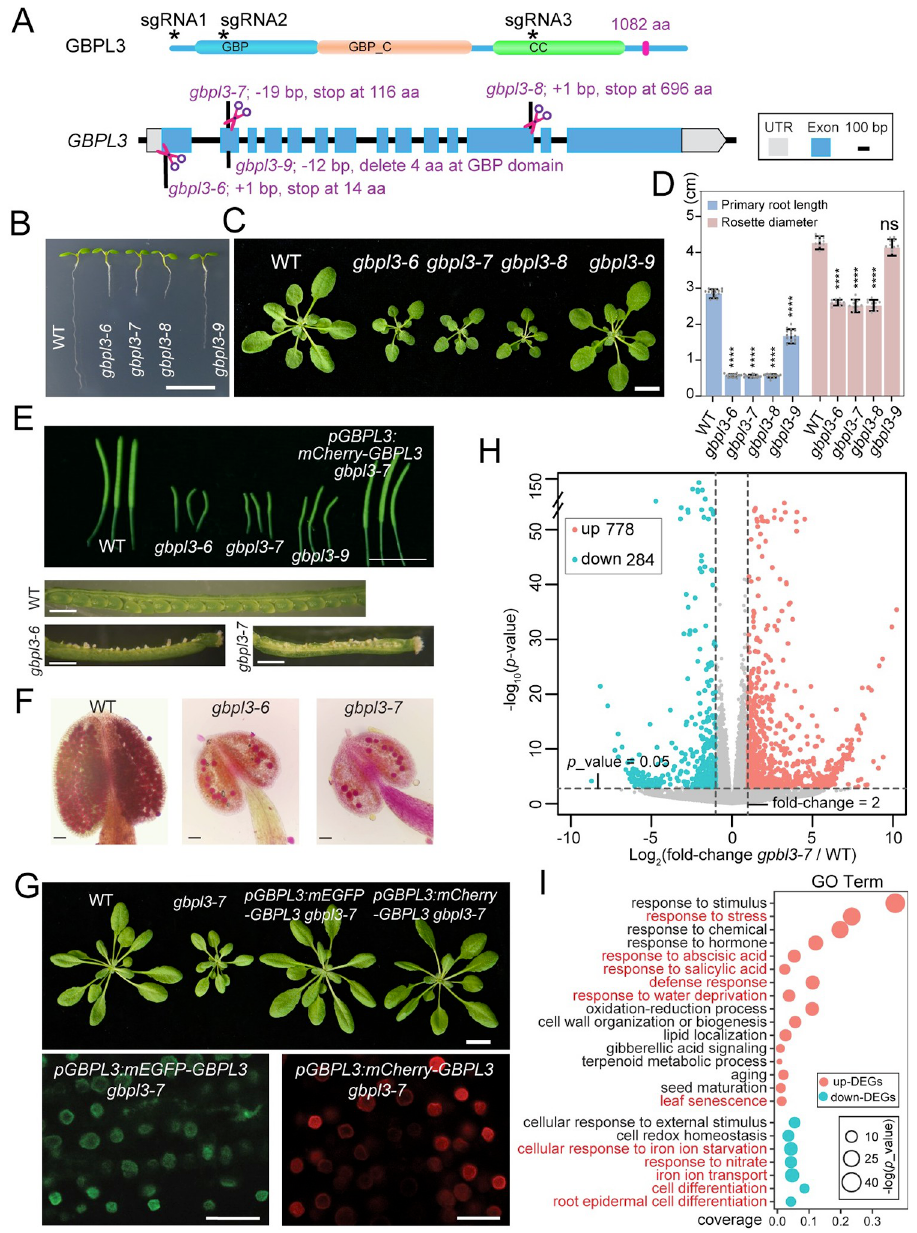
Fig 4. GBPL3 is required for plant development. (A) Four gbpl3 mutant alleles generated by CRISPR/Cas9. The upper panel shows the GBPL3 protein domain structure with 3 sgRNAs that target different regions. The lower panel describes gene editing details in different gbpl3 alleles. (B) Five-day-old WT and gbpl3 mutant seedlings. All 4 CRISPR gbpl3 mutants were confirmed by sequencing. Bar = 1 cm. (C) Four-week-old soil-grown plants. Bar = 1 cm. (D) Measurement of primary root length of 5-day-old seedlings and rosette diameter of 4-week-old plants ( n = 15 biological replicates). Student t tests were performed. ���� p -value < 0.0001; ns indicates not significant. (E) Representative siliques from 6-week-old plants. Bars = 1 cm. (F) Alexander’s staining of anthers and pollen grains in WT and gbpl3 mutants. Bars = 100 μ m. (G) Complementation of the gbpl3-7 mutant by expressing native promoter- driven mEGFP-GBPL3 or mCherry-GBPL3 (T3 generation). Four-week-old soil-grown plants are shown in the upper panel. Bar = 1 cm. The lower panel shows fluorescence imaging of GBPL3 localization in root cells of 5-day-old seedlings in the complemented lines. Bars = 10 μ m. (H) Volcano plot showing DEGs (fold-change > 2 and p - value < 0.05) in the gbpl3-7 mutant determined by RNA-seq analysis. Up- and down-regulated DEGs are displayed as pink and cyan dots, respectively. One-week-old seedlings were used ( n = 3 biological replicates). (I) GO term enrichment analysis of gbpl3 -dependent DEGs. All underlying data in Fig 4 can be found in S5 Data. DEG, differentially expressed gene; GO, gene ontology; sgRNA, single guide